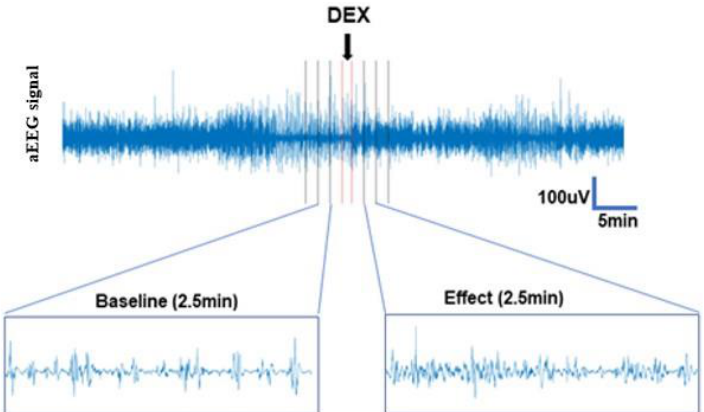
Figure 3. Short-term effects. Epochs of 2.5 min were created from the 12 and 10 min pre-(baseline) and post (effect) DEX administration periods. Due to uncertainty regarding the exact time of DEX administration, one-minute epochs before and after the administration were created, represented here as red lines.